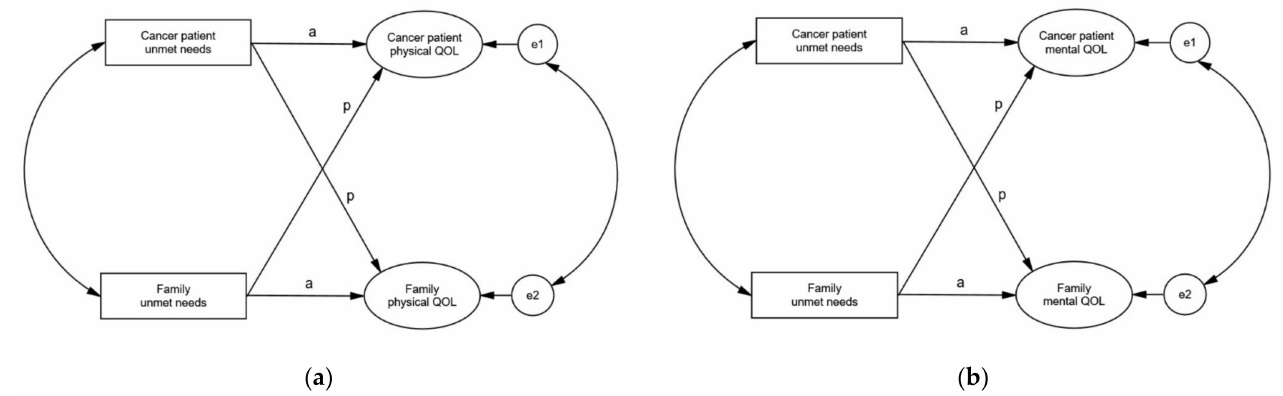
Figure 1. Hypothetical models. ( a ) Physical QOL; ( b ) Mental QOL. Note. a: actor effect; p: partner